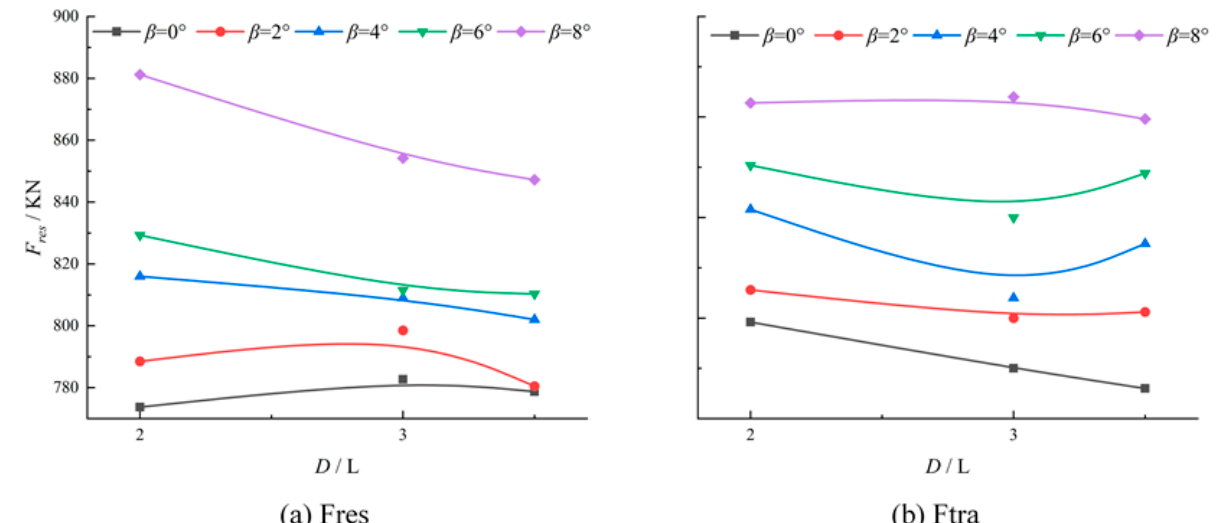
Figure 20. Average ice resistance and transverse force curves under different turning radius.